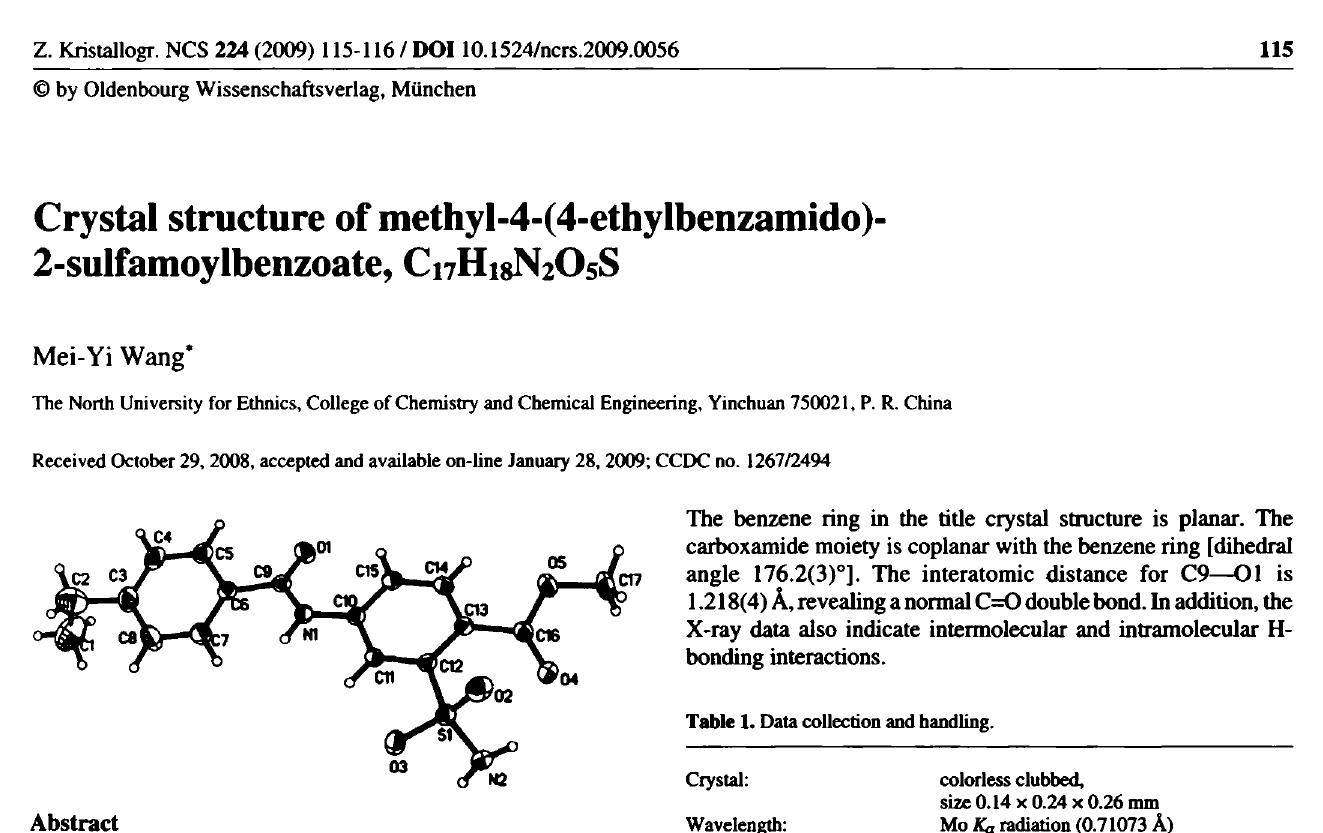
Table 2. Atomic coordinates and displacement parameters (in Â 2